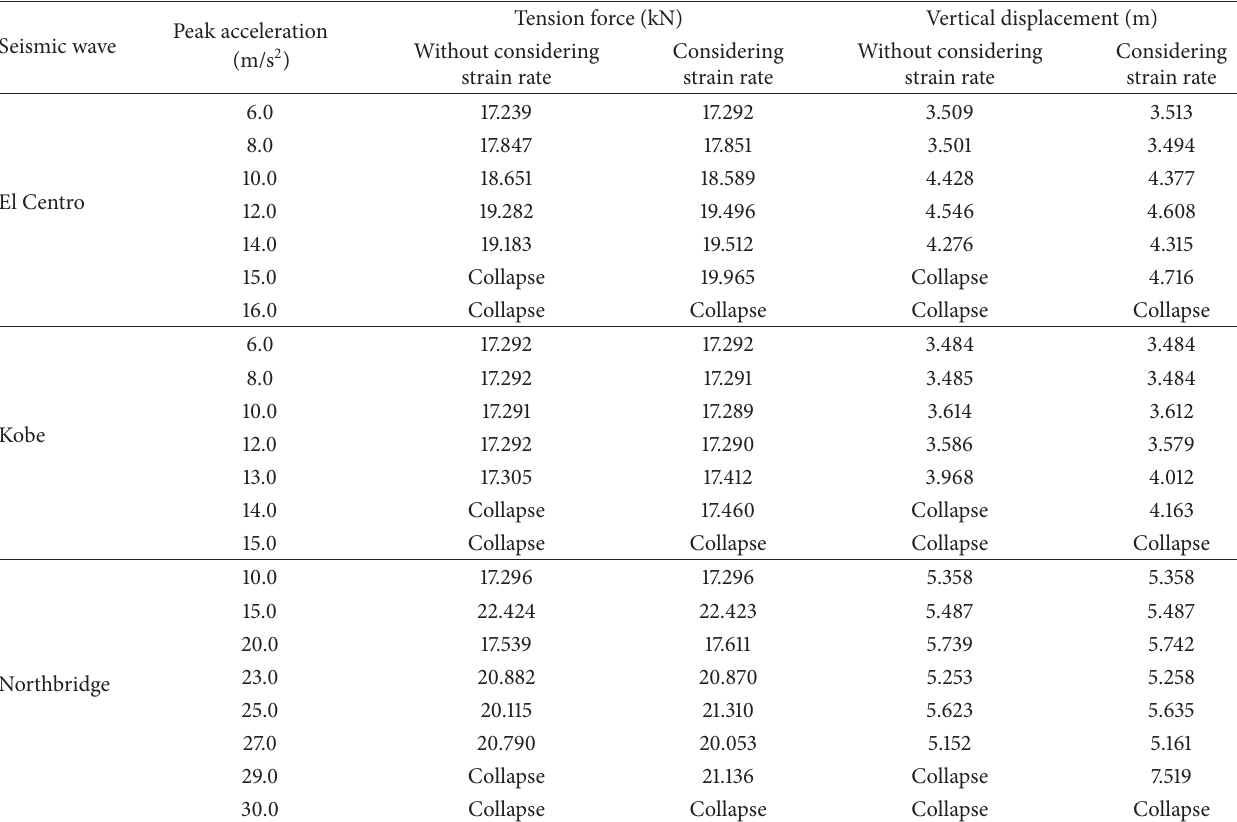
Table 6: Maximum responses of the ground